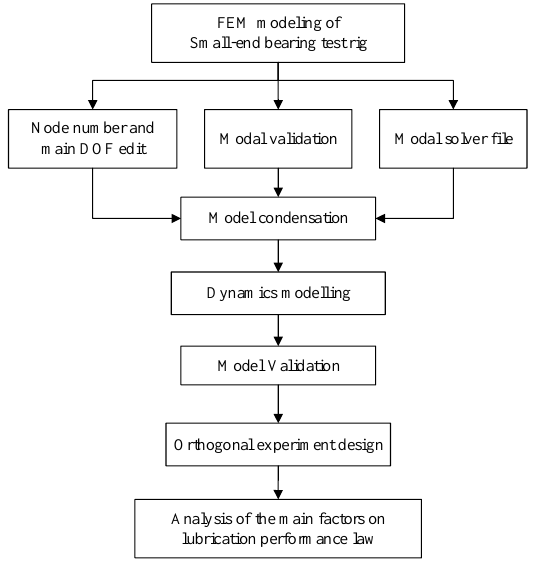
Figure 6. Piston pin dynamics analysis.